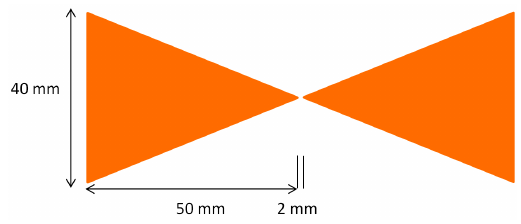
Figure 1. Dimensions of the solid bowtie antenna.